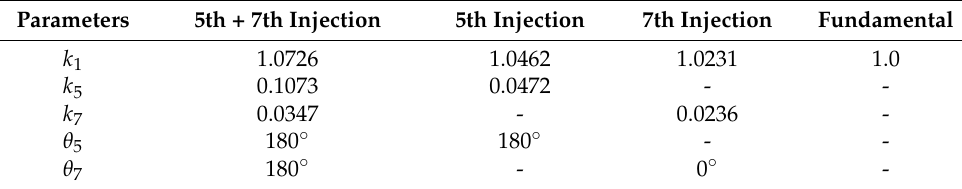
Figure 3. Current according to various optimized current-component coefficients. Table 1. Optimization results of various harmonic injection coefficients.